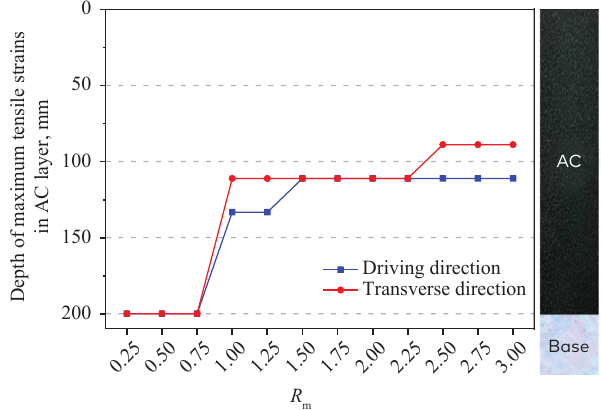
Figure 6. Depth of the maximum horizontal strains in the AC